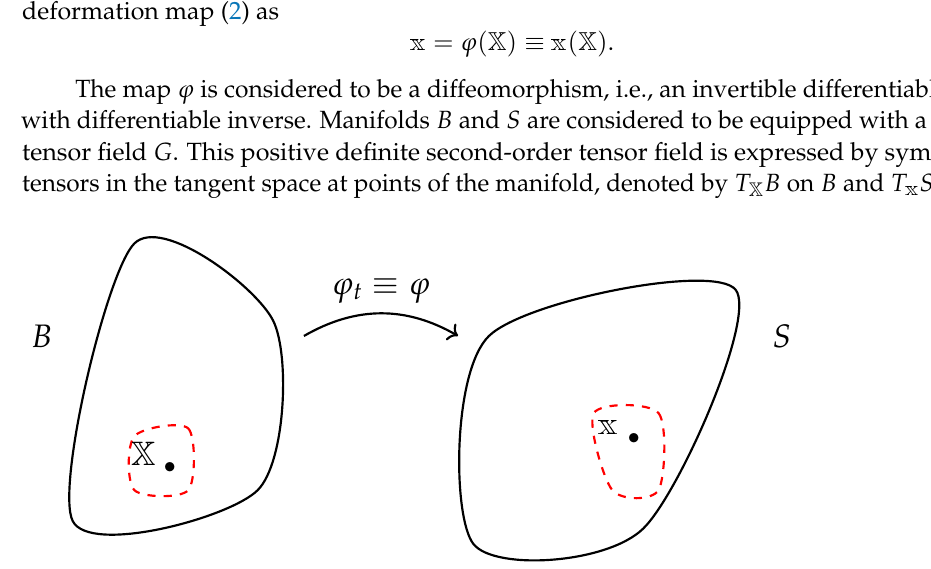
Figure 1. Initial B and current S configurations of a domain related by map ϕ t ≡ ϕ